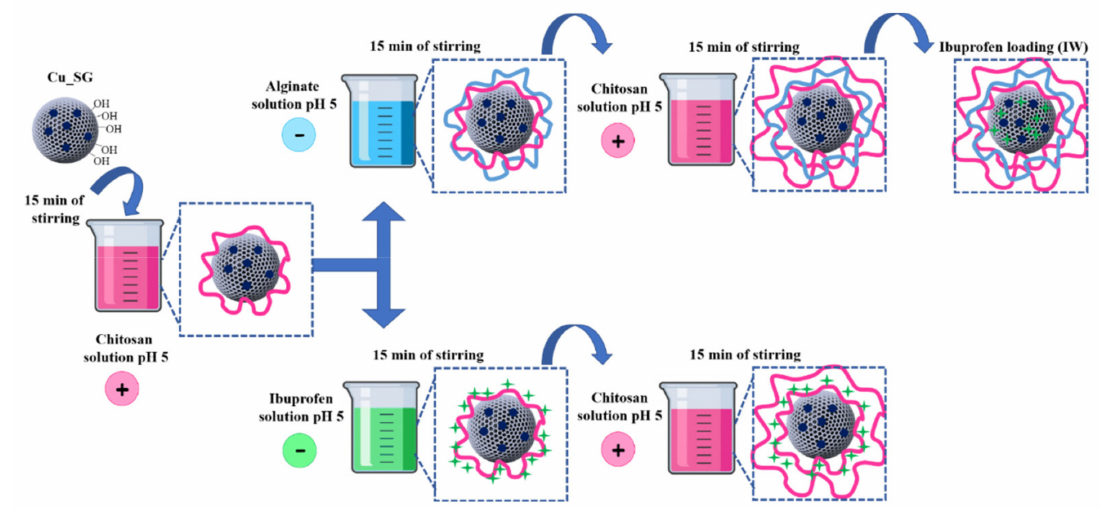
Figure 1. Schematic illustration of the two different routes adopted to produce drug delivery systems able to differently modulate the release kinetics of both copper ions and